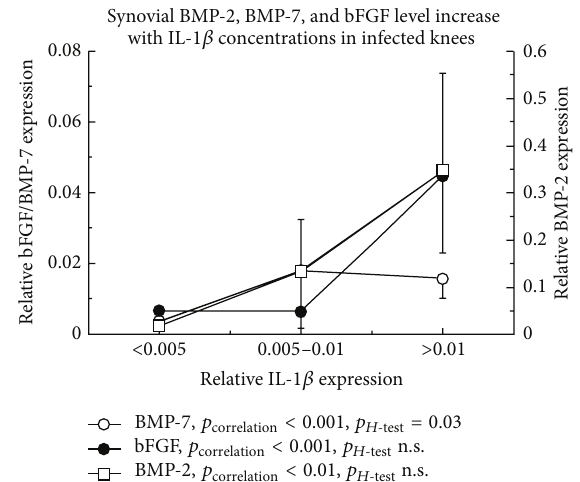
Figure 1: Increased serum leucocytes at time point of diagnosis were associated with higher collagen type 2 cleavage levels (C2C), a cartilage breakdown product. This reached statistical significance analyzing all patients and the subgroup of knee infections. Reported are the C2C levels relative to the total protein content.